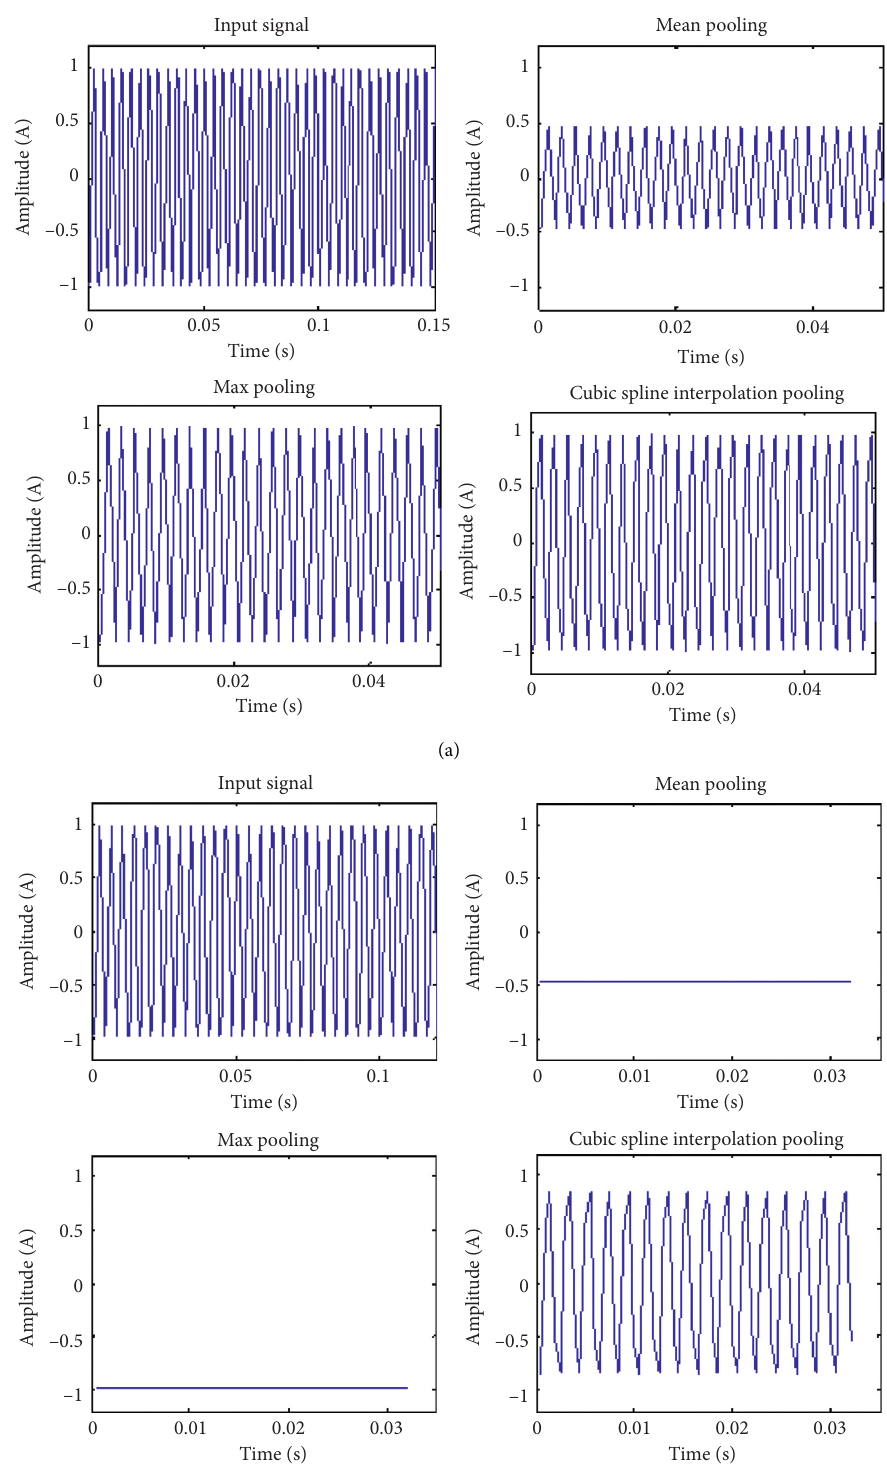
Figure 9: Time-domain waveform of the sinusoidal signals when the step size is (a) 2 and (b)